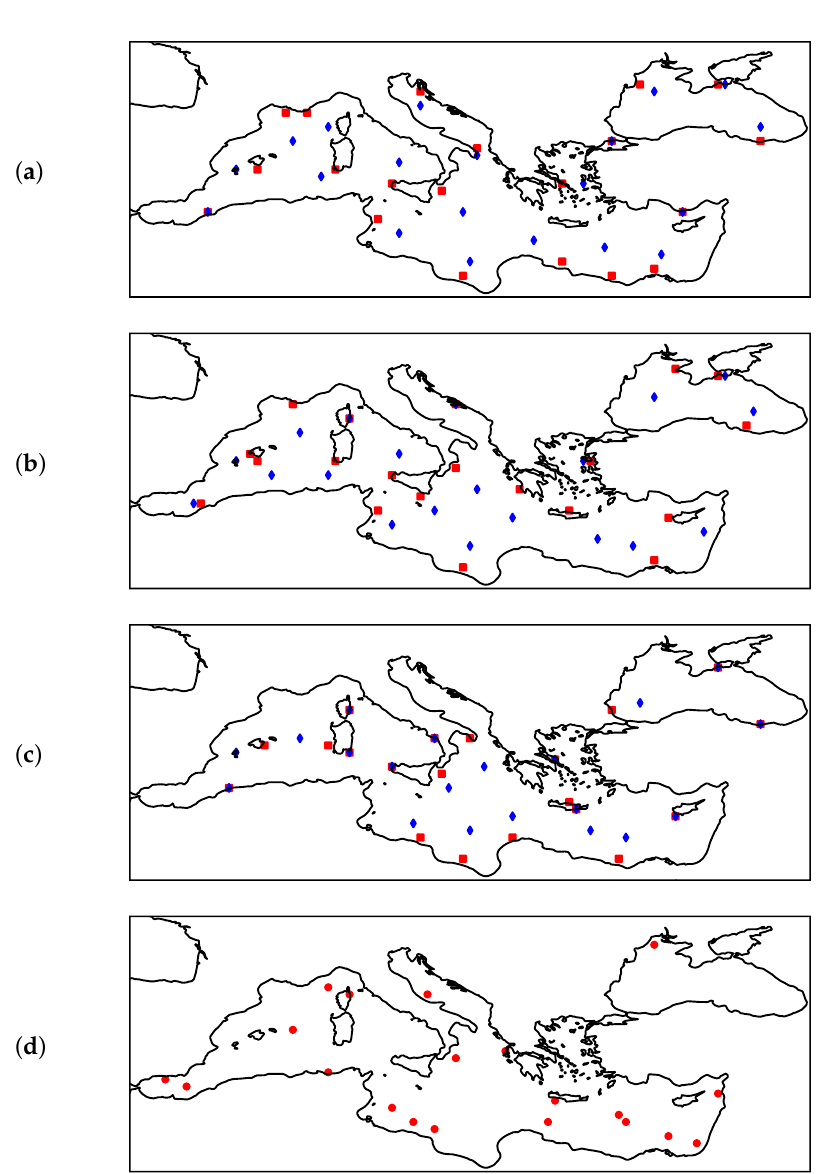
Figure 4. From ( a – d ): Optimal sensor locations for 20 sensors determined by different algorithms. ( a ) K-means algorithm: blue—default, red—alternative implementation. ( b ) GNG algorithm: blue— default, red—alternative implementation. ( c ) SOM algorithm: blue—default, red—alternative imple- mentation. ( d ) Dummy algorithm—random